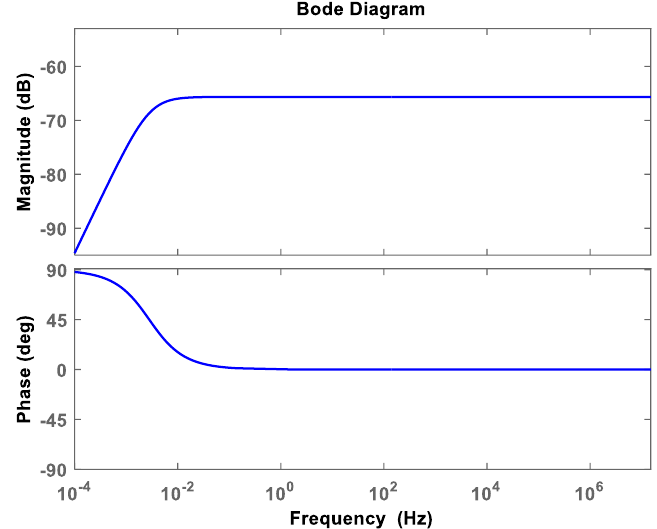
Figure 8. Response curves of amplitude-frequency and phase-frequency of the sensor.